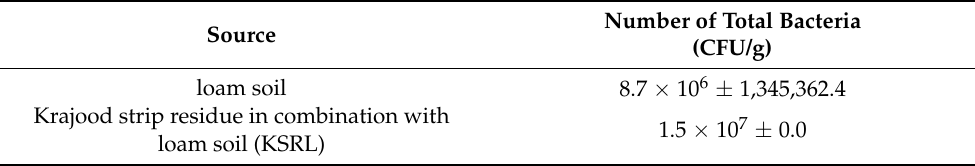
Table 3. Numbers of total bacteria from loam soil (LS) and KSRL.